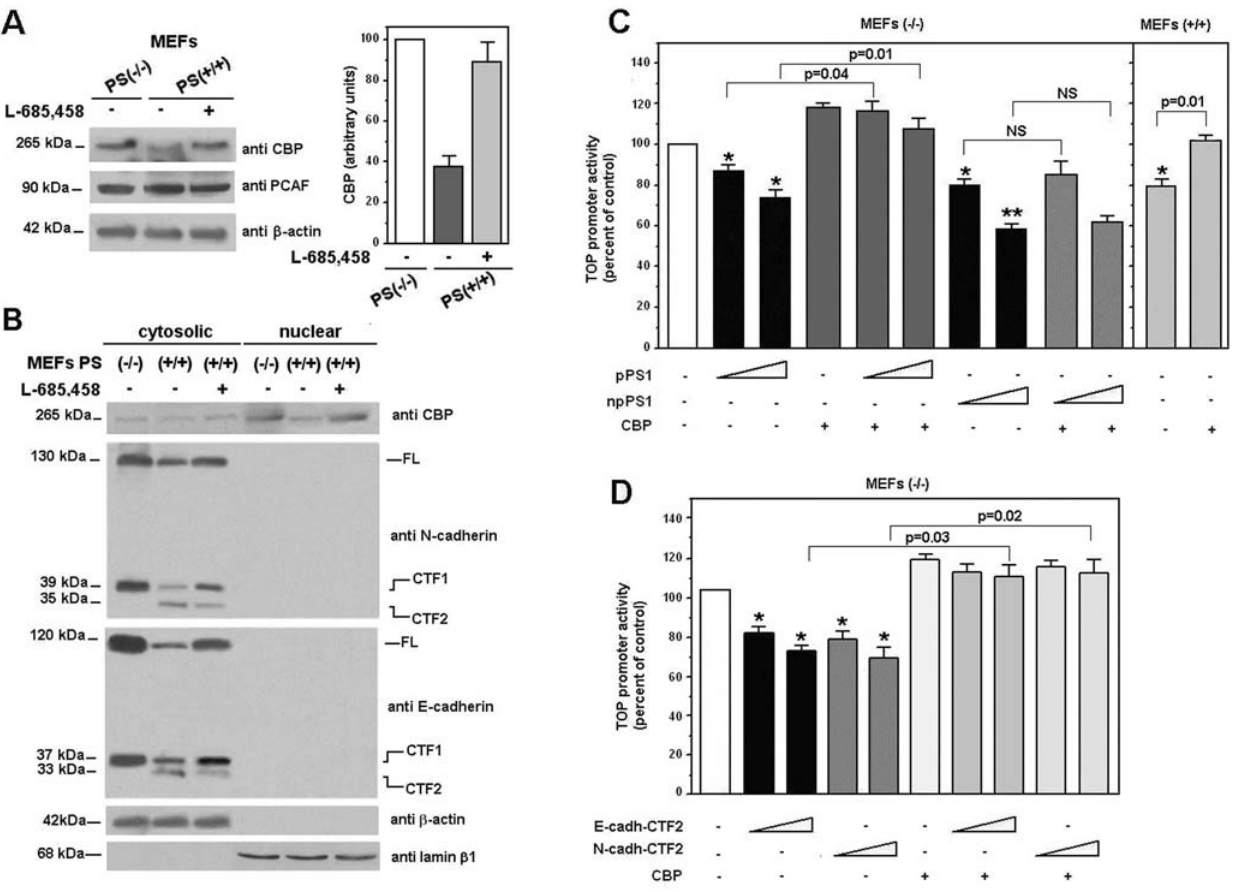
Figure 6. CBP prevents the repression of b -catenin ? Tcf-4 transcriptional activity caused by the expression of pPS1, E- or N-cadherin CTF2. (A) MEF PS ( + / + ) cells were incubated with 5 m M c -secretase inhibitor L-685,458 for 24 h. 50 m g of MEFs PS ( 2 / 2 ) and PS ( + / + ) total cell extracts were analyzed by SDS-PAGE and Western blot with anti-CBP and anti- b -actin antibodies. Autoradiograms were scanned and the average level of CBP obtained in the three different experimental conditions is represented in the right panel. Values correspond to the average + / 2 S.D of four experiments. (B) Cytosolic and nuclear-associated fractions of MEF PS ( 2 / 2 ) and PS ( + / + ) cells (incubated with 5 m M c -secretase inhibitor L-685,458) were prepared as detailed in Experimental Procedures . 50 m g of each fraction was analyzed by SDS-PAGE and Western blot with the indicated antibodies. (C) MEF PS ( 2 / 2 ) cells were cotransfected with either pcDNA3.1-PS1 (pPS1) or pcDNA3.1- Myc/His -PS1 (npPS1) and pcDNA3.1-HA-CBP and (D) with pcEGFPC1-E-cadh-CTF2 or pcDNA3.1-N-cadh-CTF2 or empty vector (150–300 ng), TOP-FLASH (50 ng) and pTK- Renilla (10 ng) luciferase plasmids. Relative luciferase activity was determined with a dual luciferase reporter assay system 48 h after transfection, and the result was normalized using the Renilla luciferase activity for each sample. Percentage activity was calculated by comparing levels of luciferase activity with levels after transfection of the empty plasmid alone. Values are the average + / 2 S.D. of three-four experiments performed in triplicate. (*) indicates p , 0.05; (**), p , 0.01; in the rest of the comparisons, the p value is shown. NS, not